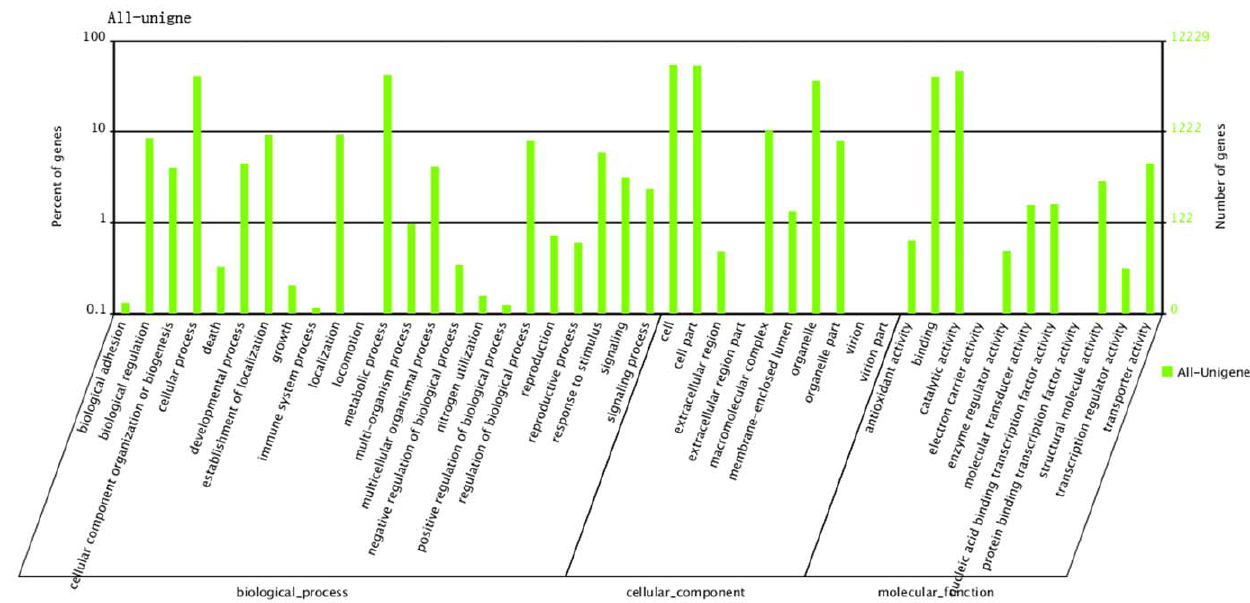
Figure 2. GO categories assigned to the safflower unigenes.